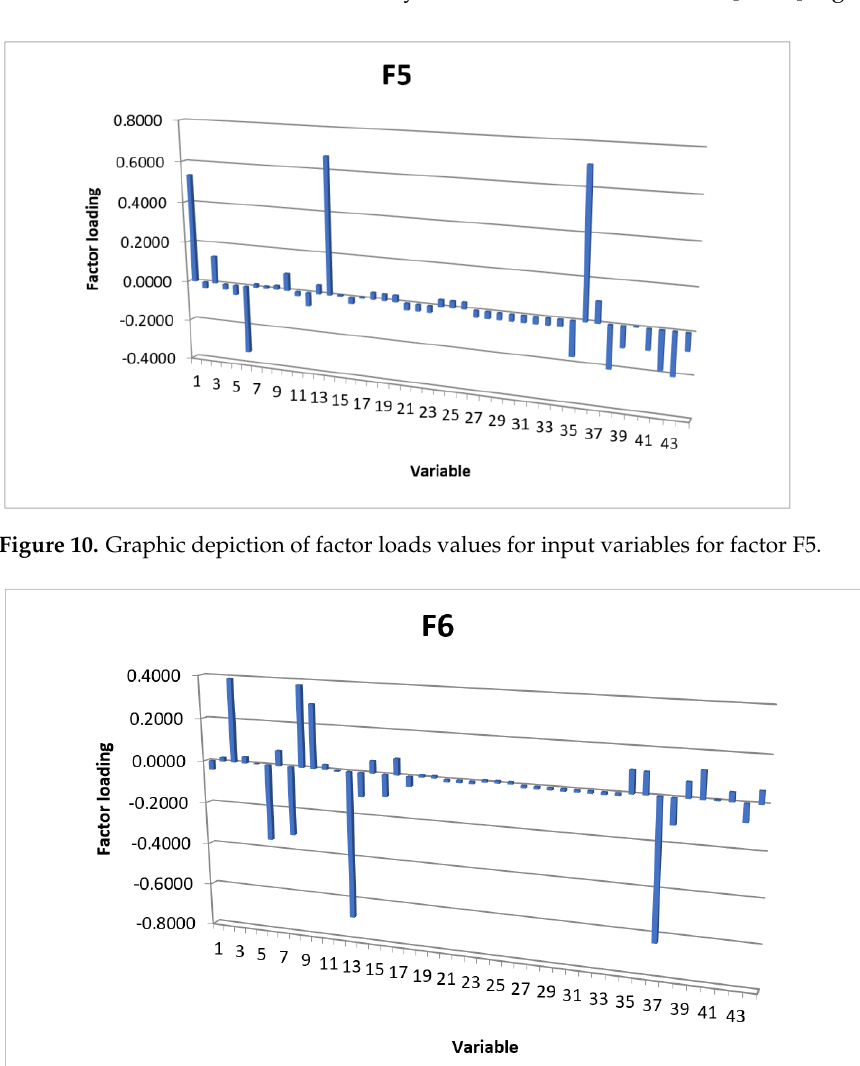
Figure 10. Graphic depiction of factor loads values for input variables for factor F5.